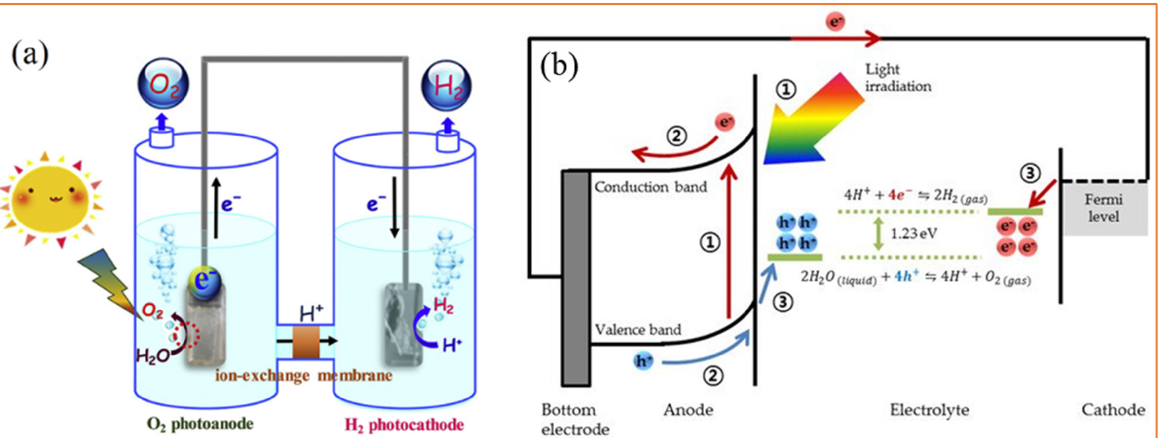
Figure 2. ( a ) Schematic device illustration of photoelectrochemical water splitting. Reprinted with permission from Ref. [38] (Copyright 2019 Elsevier). ( b ) Schematic representation of the photoelectrochemical water splitting process in a common PEC water splitting system consisting of a photoanode and a metal counterpart. Reprinted from Ref. [39].